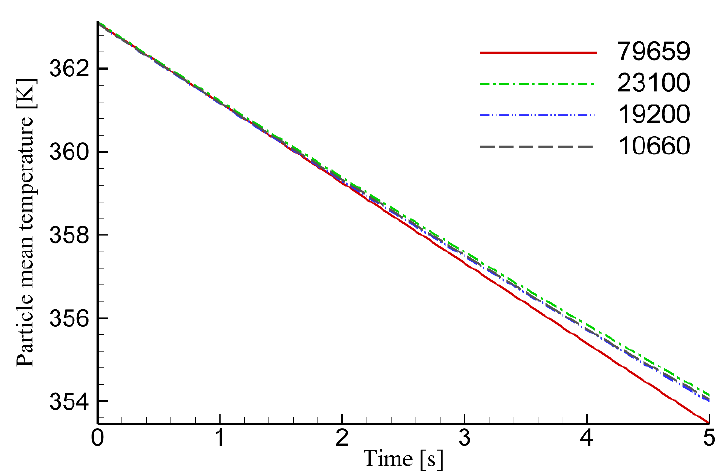
Figure 2. Variation in the particles’ mean temperature with the time at four different grid sizes.